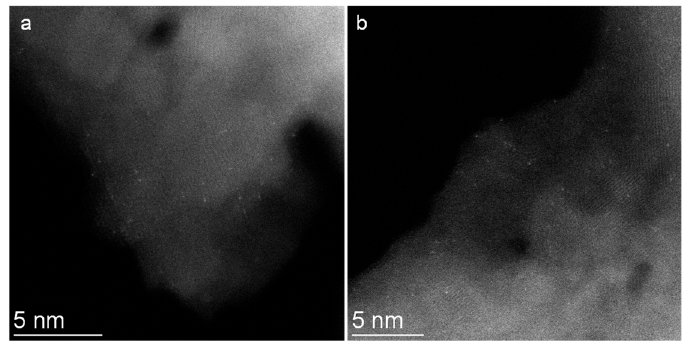
Figure 2. HAADF-STEM images of Pd@MgO catalyst ( a , b ).